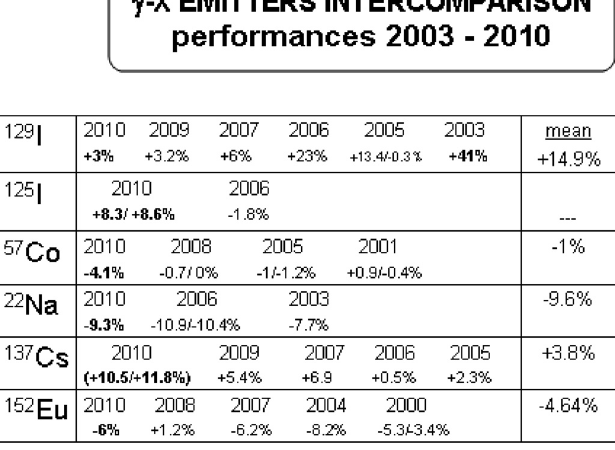
Fig. 6. Evolution of the performance between 2000 and